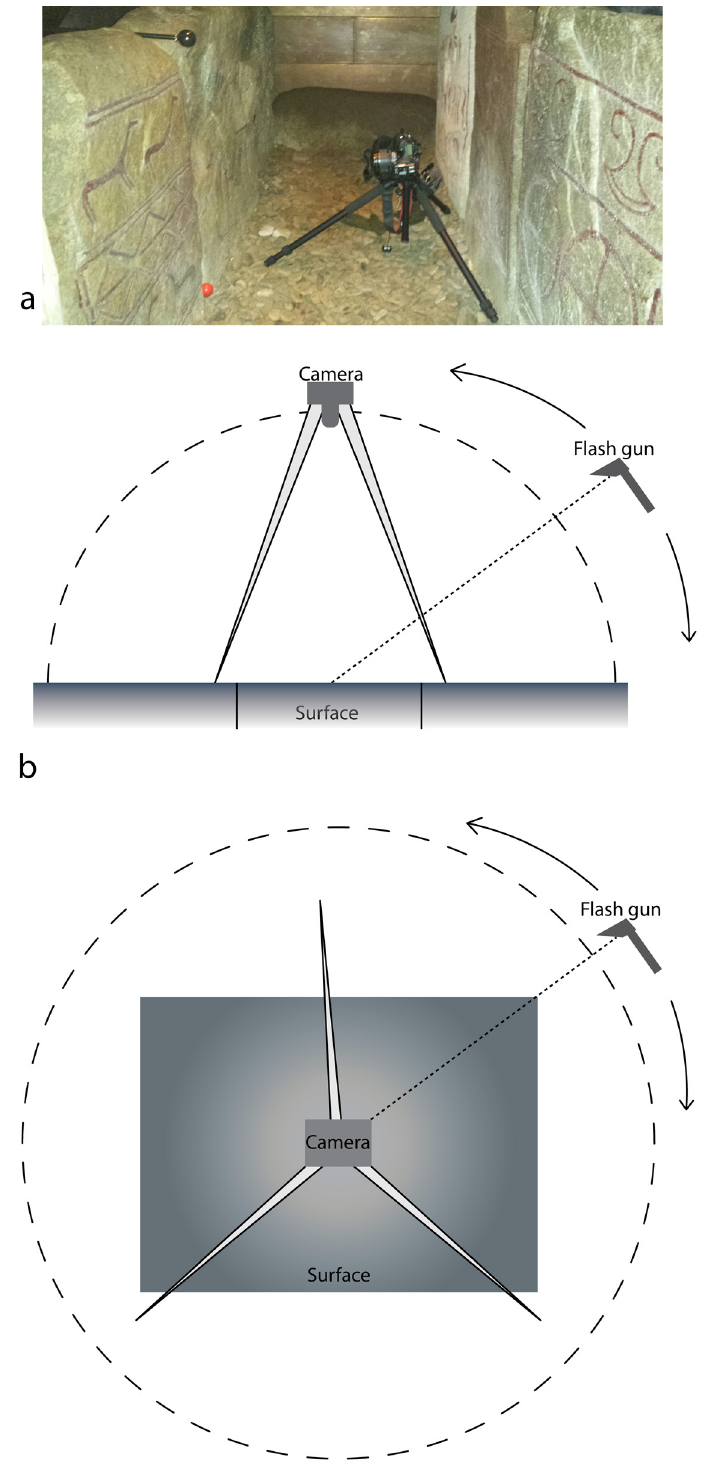
Figure 1. a. camera setup in the Bredarör tomb in Kivik, Sweden; b. schematic camera setup and process to record non-vertical rock art